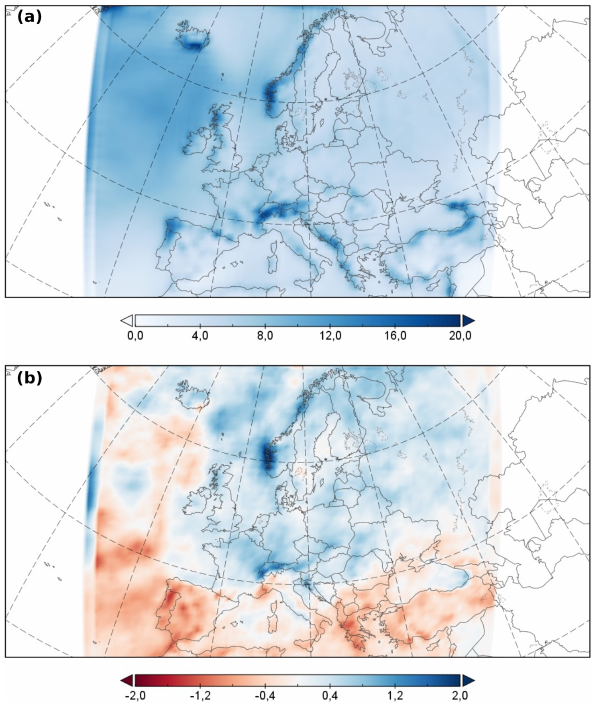
Figure 8. (a) Precipitation (mmd − 1 ) for the present (1991–2010) period. (b) Difference (mmd − 1 ) between the future (RCP8.5, 2031–2050) and the present (1991–2010)